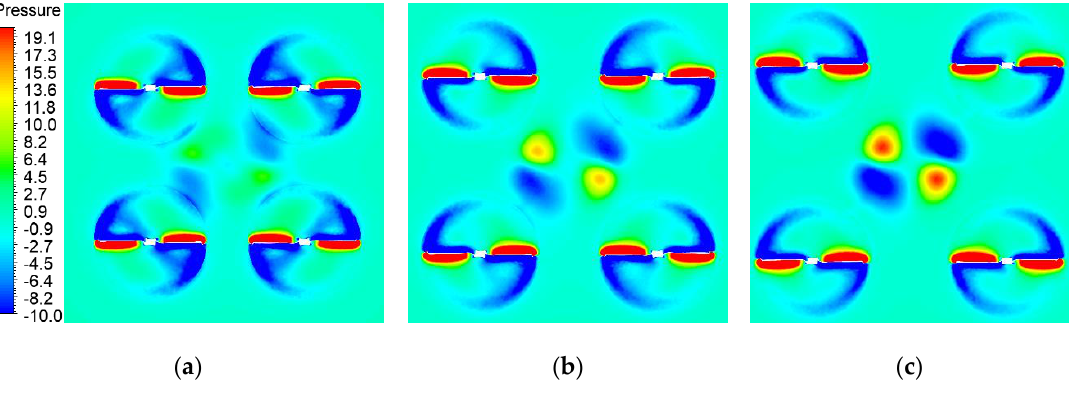
Figure 9. Pressure distribution at Re = 0.89 × 10 5 ( a ) i = 0.71; ( b ) i = 0.63; ( c ) i = 0.56.